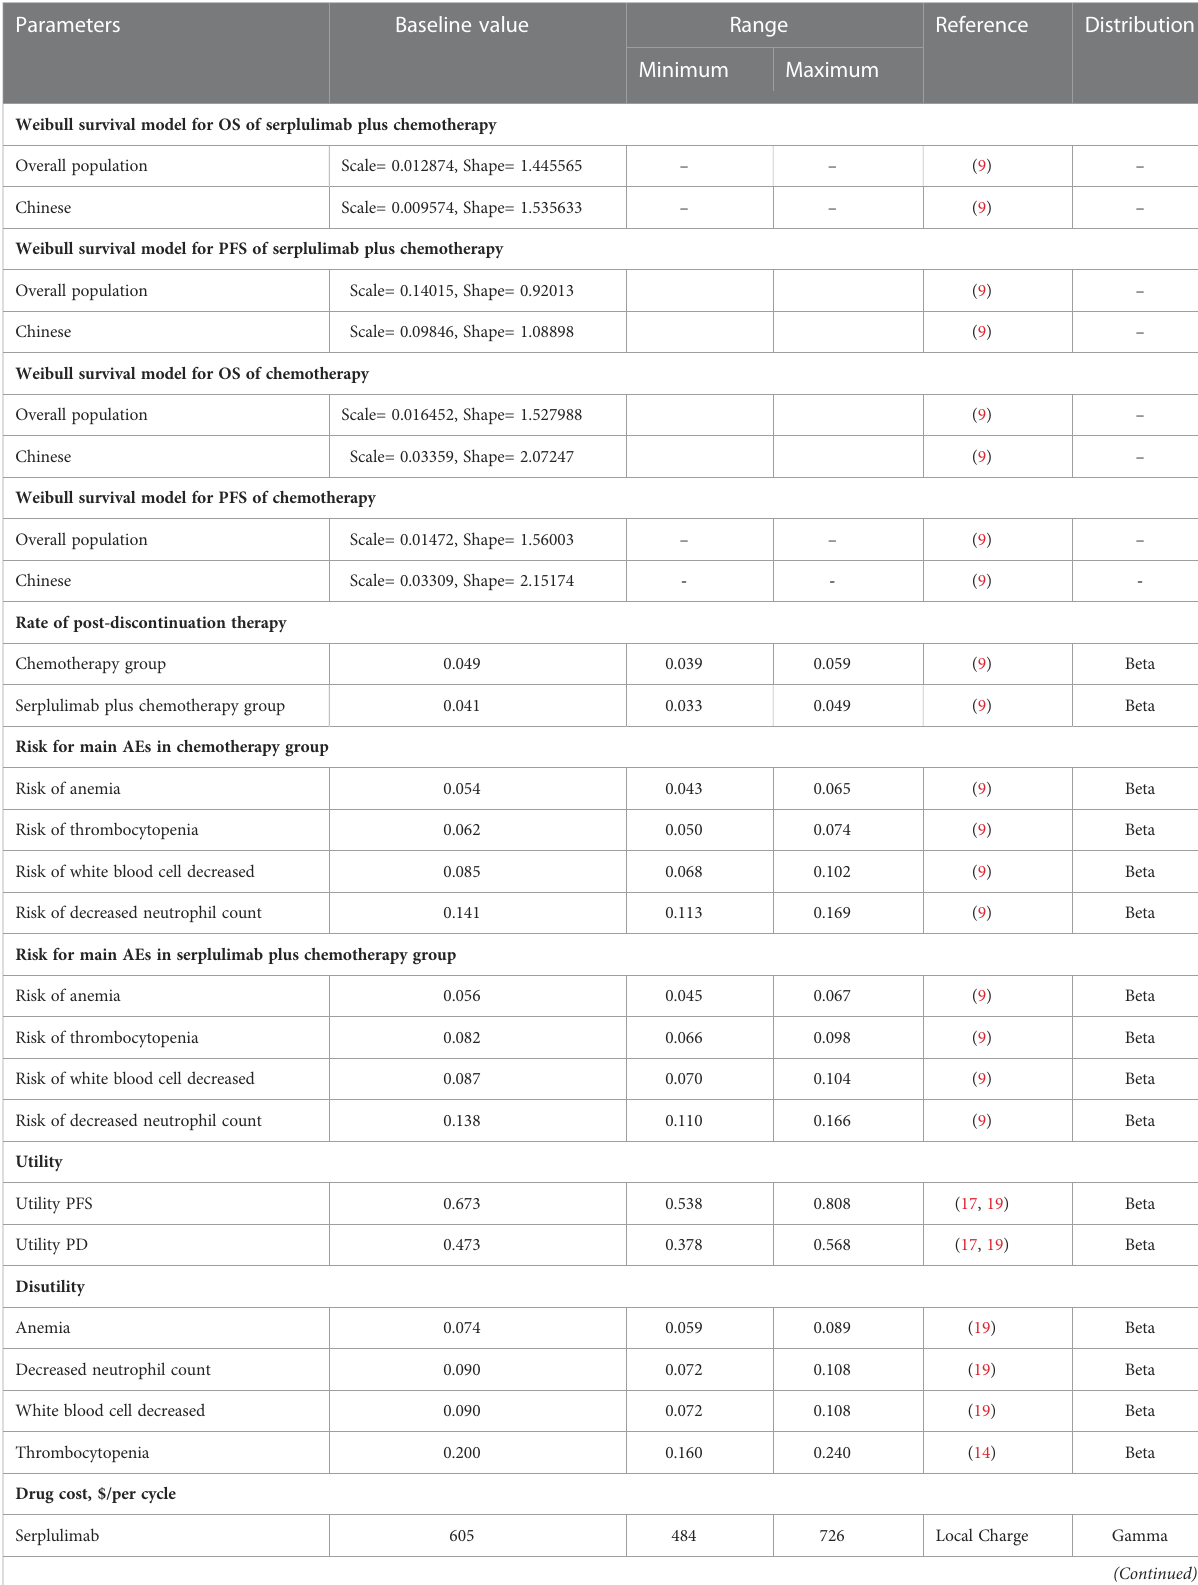
TABLE 1 Model parameters: baseline values, ranges, and distributions for the sensitivity